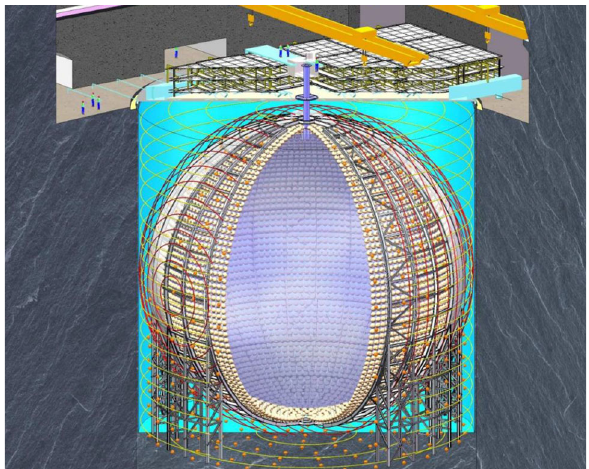
Fig. 2 Layout of the JUNO detector